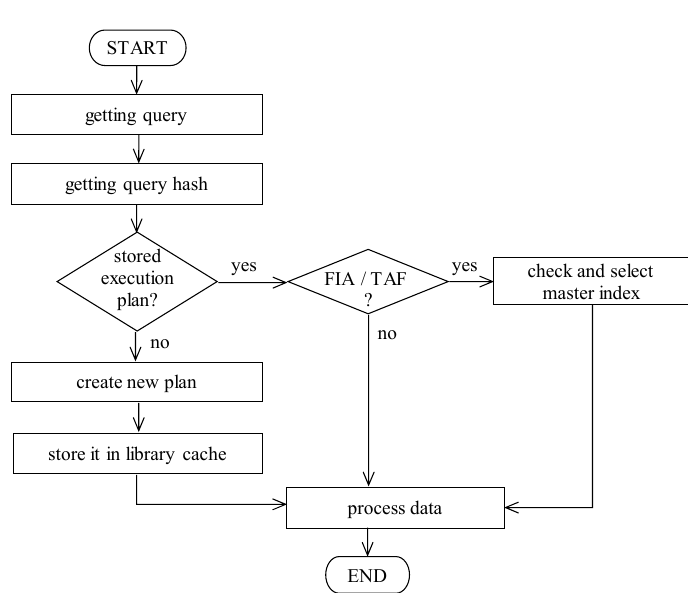
Figure 15. Managing and evaluating execution plans. FIA, flowering index approach; TAF, table access full.